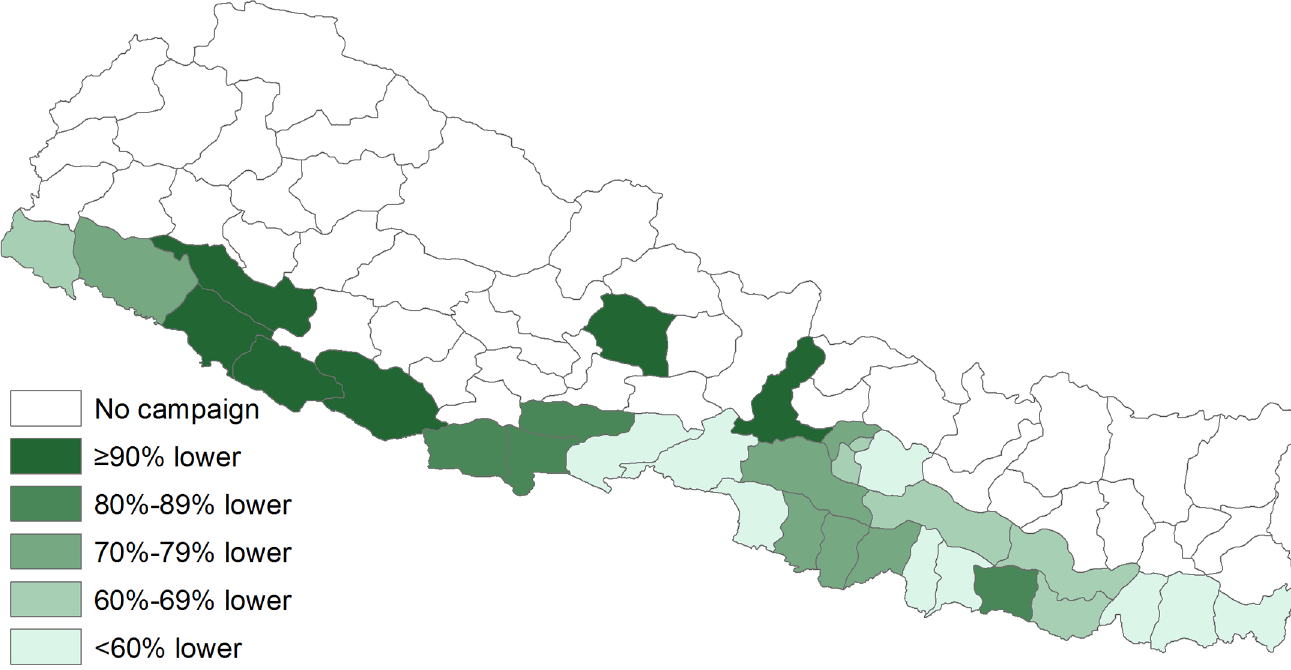
Fig 1. Percent difference in expected and observed incidence of Japanese encephalitis following vaccination campaign, by district, Nepal.